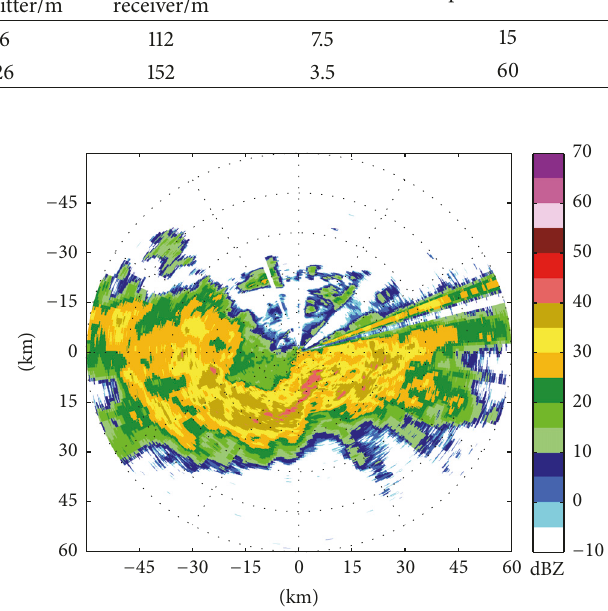
Figure 4: Reflectivity PPI at elevation 1 ∘ of the X-band radar at 0746 UTC, 2 June 2015. The circles correspond to radar ranges of 12, 24, 36, 48, and 60 km,